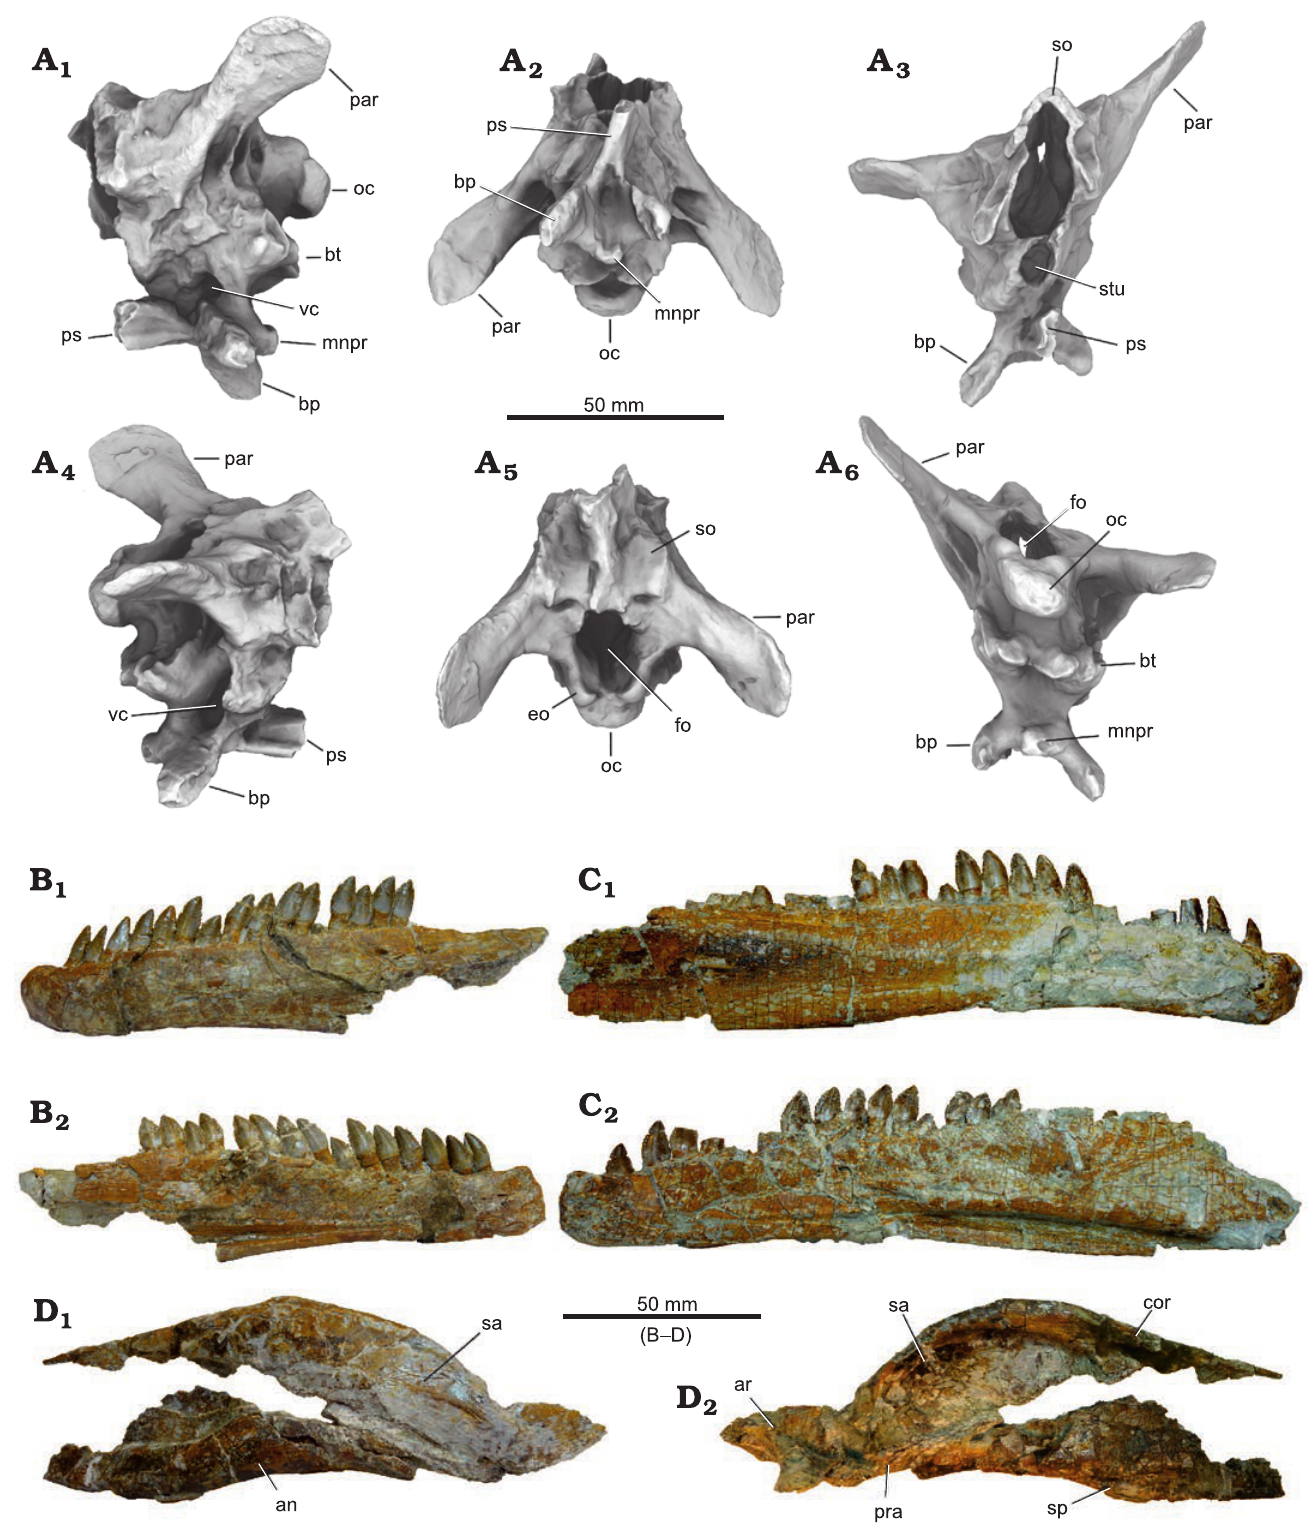
Fig. 14. Disarticulated skull elements of Plateosaurus trossingensis (MSF 07.M) from the Triassic of Frick, Switzerland. A . Ambient occlusions of photo- grammetric model of the braincase in left lateral (A 1 ), ventral (A 2 ), anterior (A 3 ), right lateral (A 4 ), dorsal (A 5 ), and posterior (A 6 ) views. B . Left dentary in lateral (B 1 ) and medial (B 2 ) views. C . Right dentary in lateral (C 1 ) and medial (C 2 ) views. D . Posterior part of mandible in lateral (D 1 ) and medial (D 2 ) views. Abbreviations: an, angular; ar, articular; bp, basipterygoid process; bt, basipterygoid tubera; cor, coronoid; eo, exoccipital; fo, foramen magnum; mnpr, median process; oc, occipital condyle; par, paroccipital process; pra, prearticular; ps, parasphenoid; sa, surangular; so, supraoccipital; sp, splenial; sq, squamosal; stu, sella turcica; vc, exit of vidian